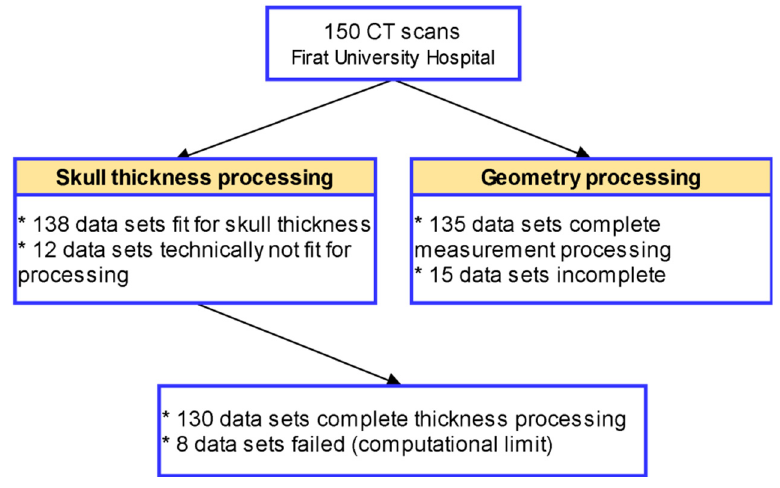
Figure 9. Flowchart of the CT processing in the study.